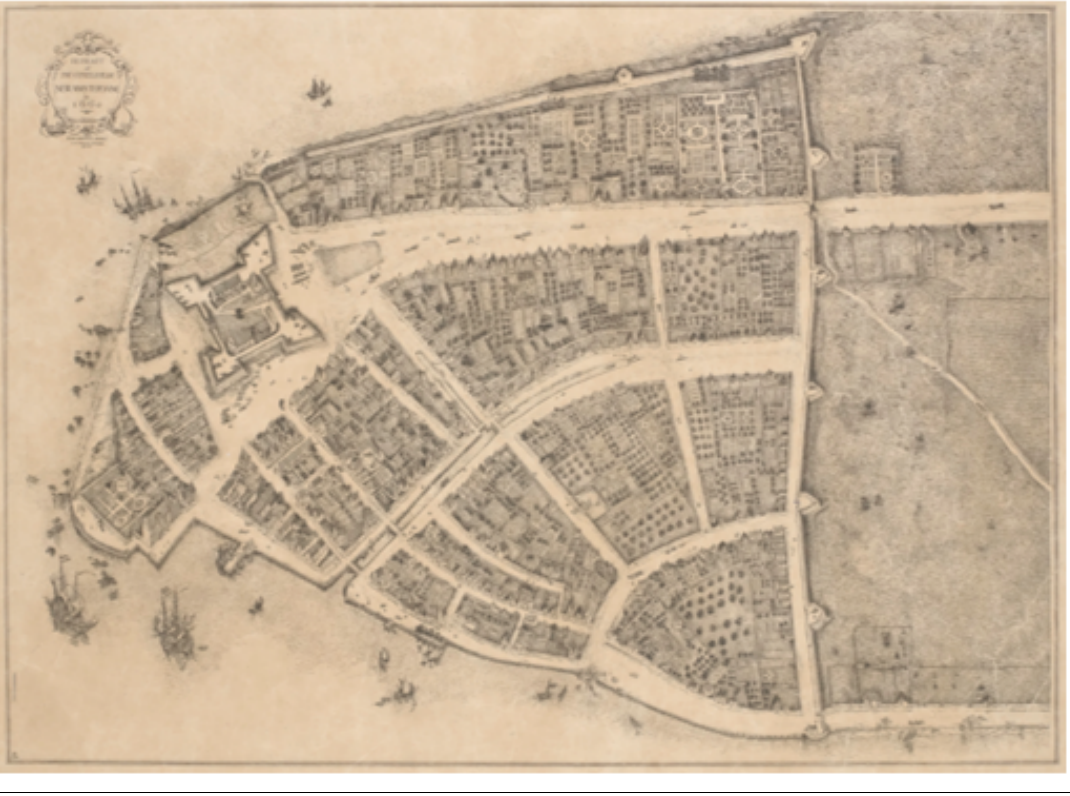
Figure 1. Redraft of the Castello Plan, New Amsterdam in 1660 (Source: New York Public Library Digital